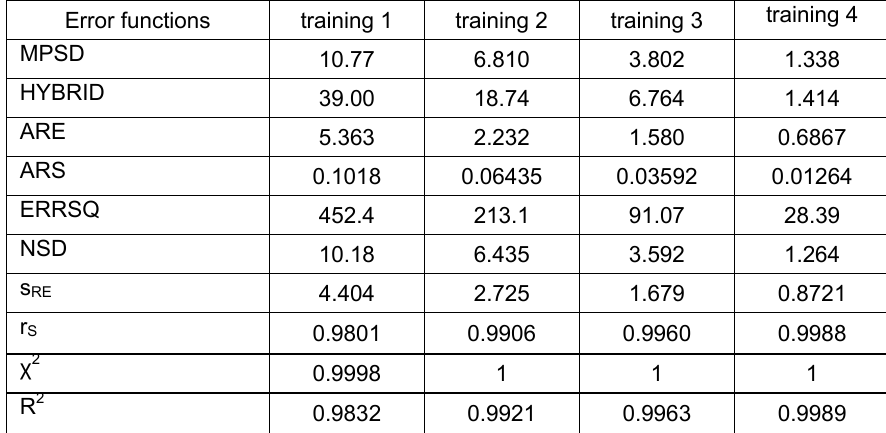
Table 7 – Errors for four ANFIS training sets for the variable R Таблица 7 – Ошибки в четырех этапах обучения ANFIS по переменной